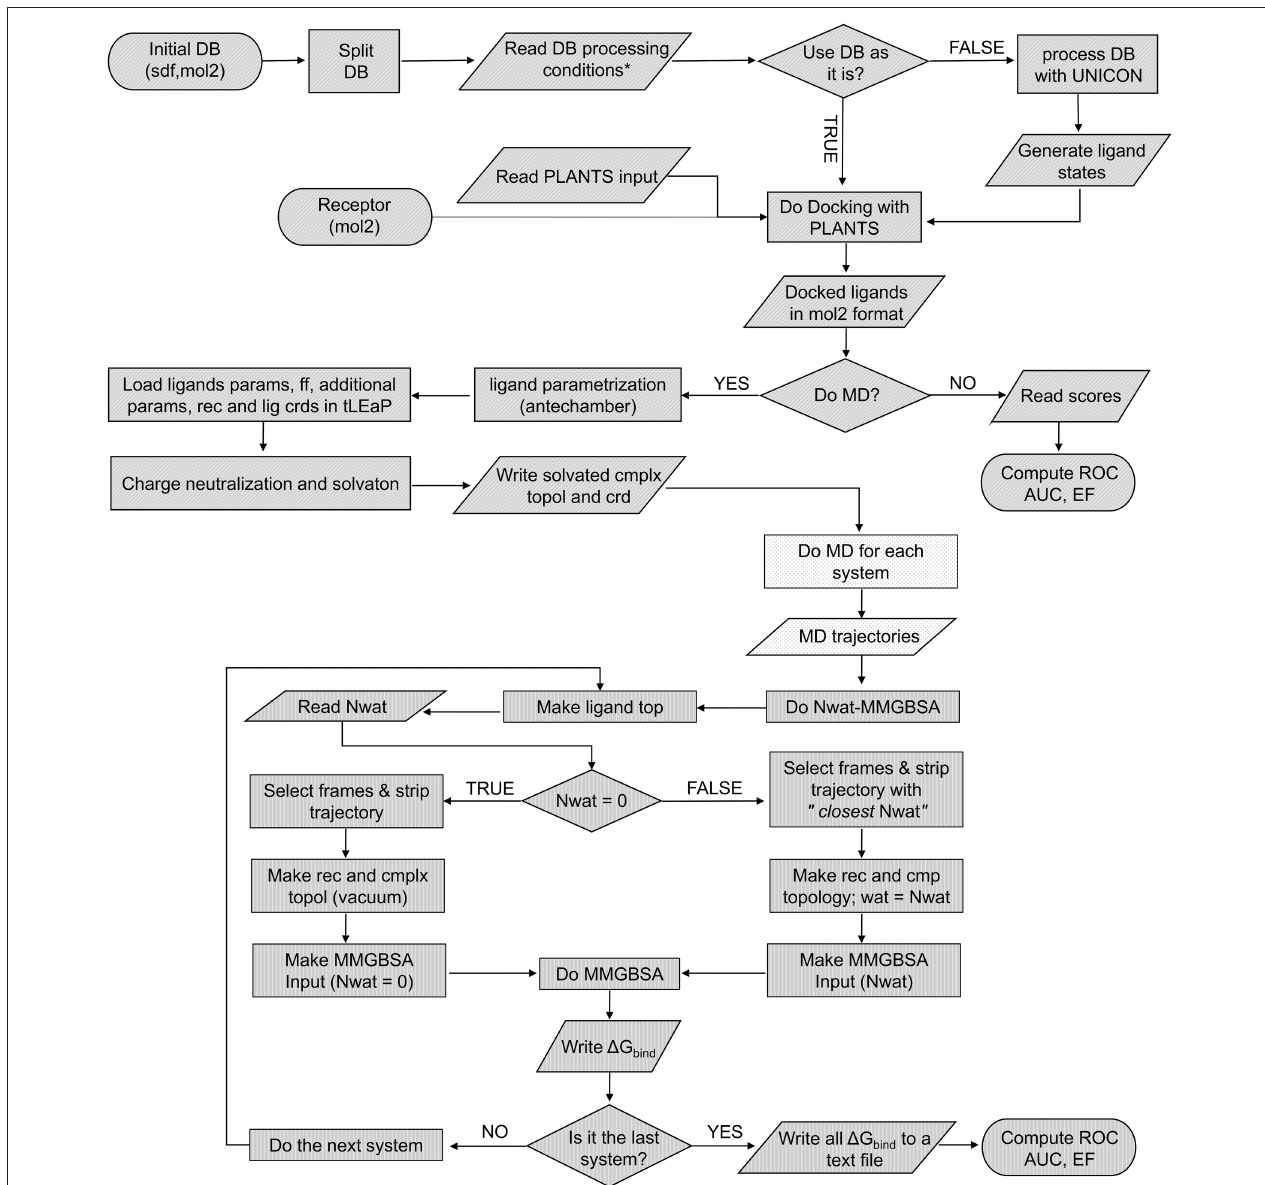
FIGURE 1 | Pseudocode of the complete screening and rescoring workflow. Each texture represents an independent script: VScreen (diagonal), autoMD (dots), and Nwat-MMGBSA (vertical).